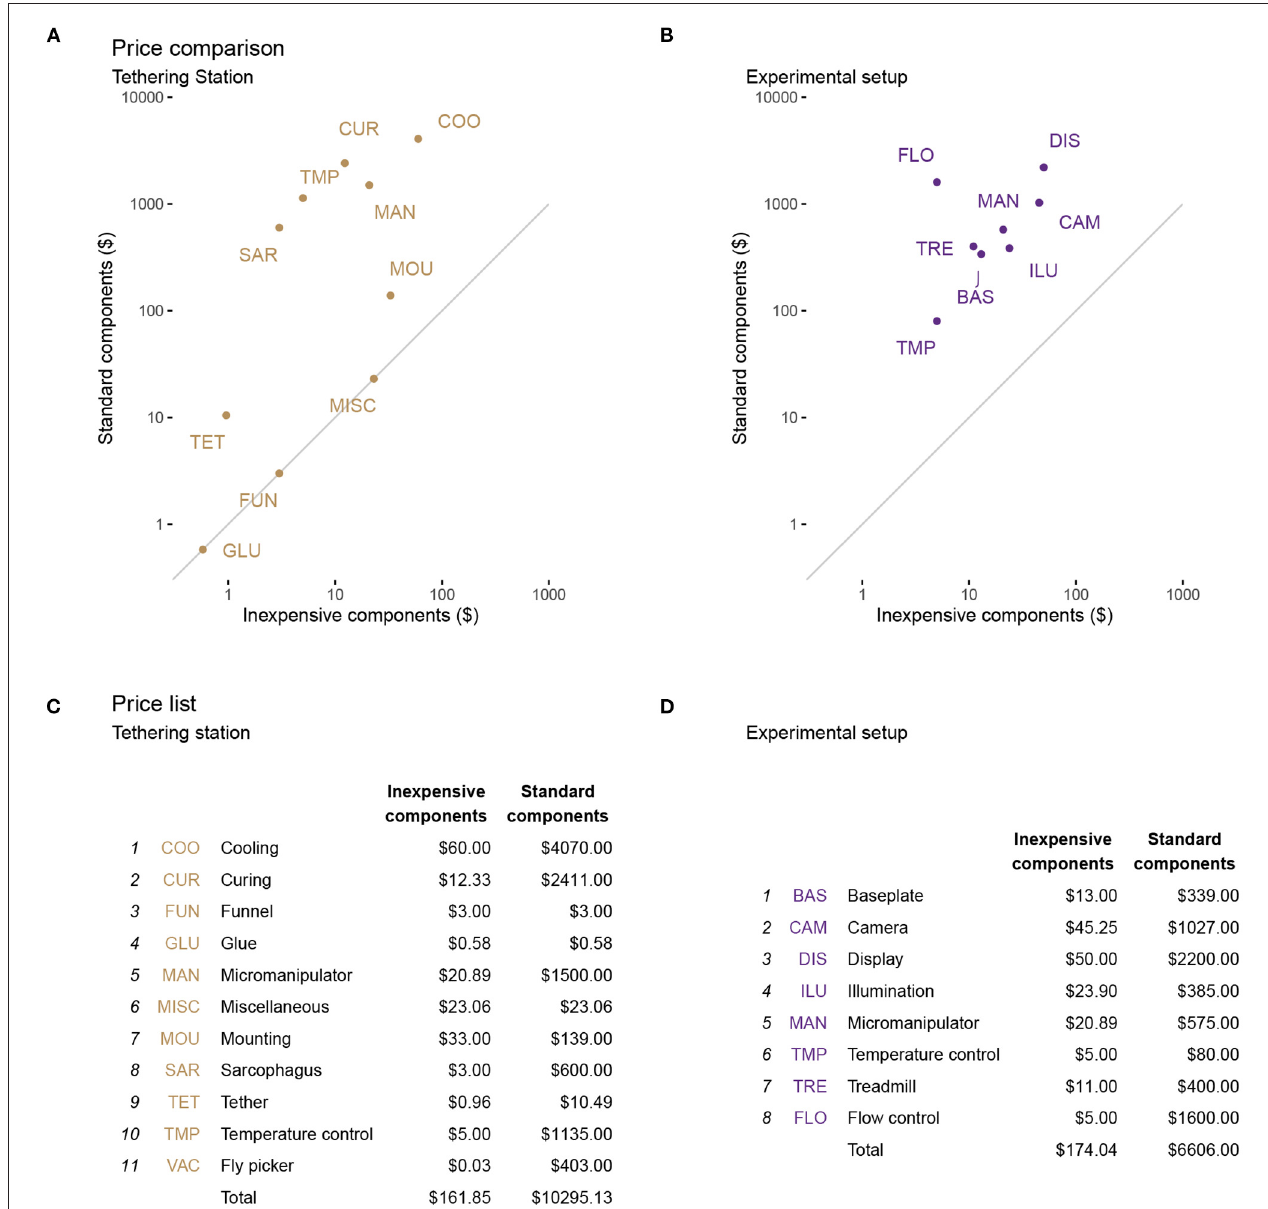
FIGURE 6 | Estimated cost savings for each setup. The price of each functional unit is a comparison between the standard setups and the optimized, inexpensive tethering station (A) and experimental (treadmill) setup (B) . The diagonal line in each of (a), (b) represents an equal price in both setups. In (C,D) , we list the components (or functional units) represented by the labels in (A,B) . We use a projected maximum of weekly consumptions for expendables (e.g., glue and tethers). Between the two versions of these systems, we estimate a ∼ 50-fold cost saving. Further details are provided in the text and in Tables 1 , 2 , detailing these